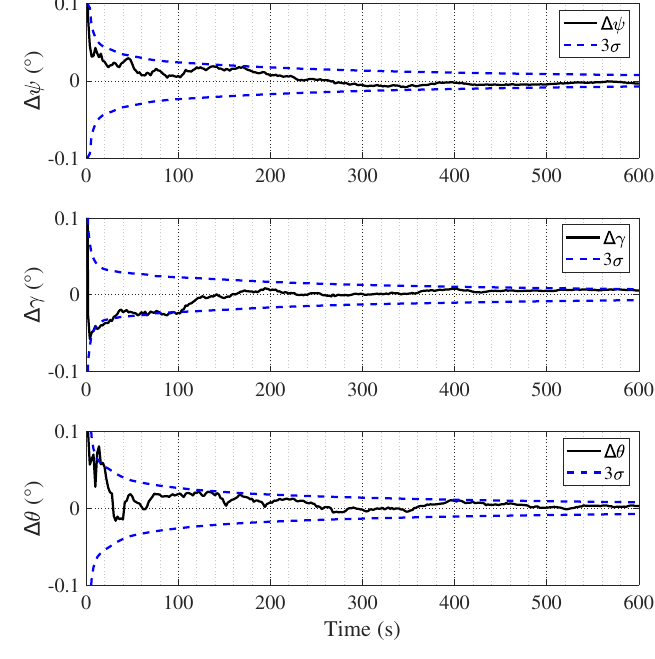
Figure 14. Attitude error.